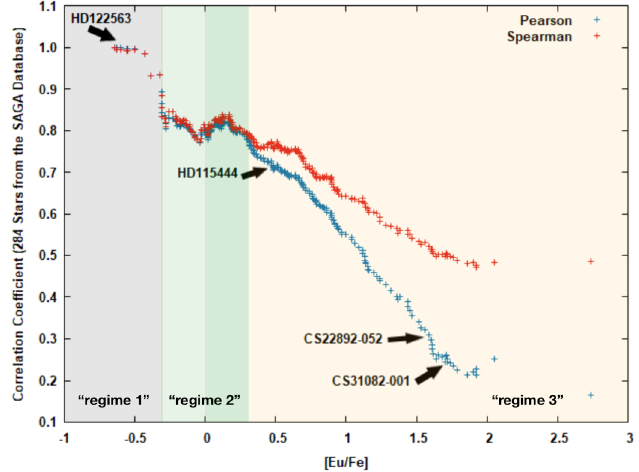
Figure 6. Shown are the Pearson and Spearman correlation coe ffi cients for low-metallicity stars ([Fe / H < -2.5) from the JINAbase database [29], considering stars in an [Eu / Fe] interval with its upper limit displayed on the x-axis. We see for limited-r stars of regime 1 and 2 a high correlation, indicating Fe and Eu co-production, while for r-enriched stars of regime 3 the correlations vanish, arguing for separate nucleosynthesis sources for the Fe and Eu found in these stars. Four typical stars (HD122563, limited-r), HD115444 (r-enriched, r-I), CS22892-052 (r-enriched, r-II), and CS31082-001 (r-enriched, r-II with actinide boost) are displayed as